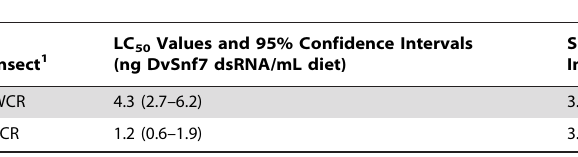
Table 1. Western Corn Rootworm (WCR, Diabrotica virgifera virgifera ) and Southern Corn Rootworm (SCR,